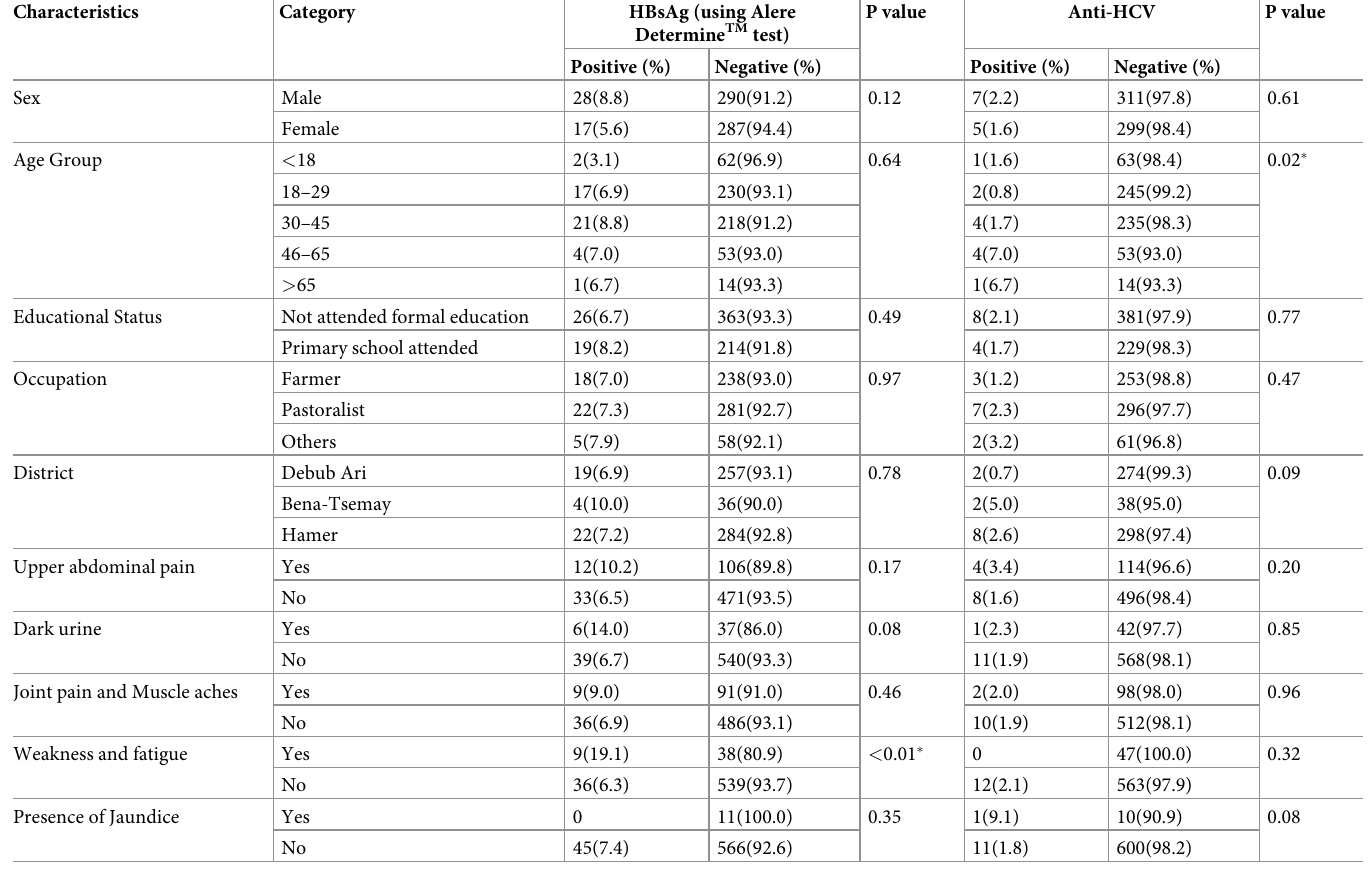
Table 3. Sero-prevalence for HBV and HCV